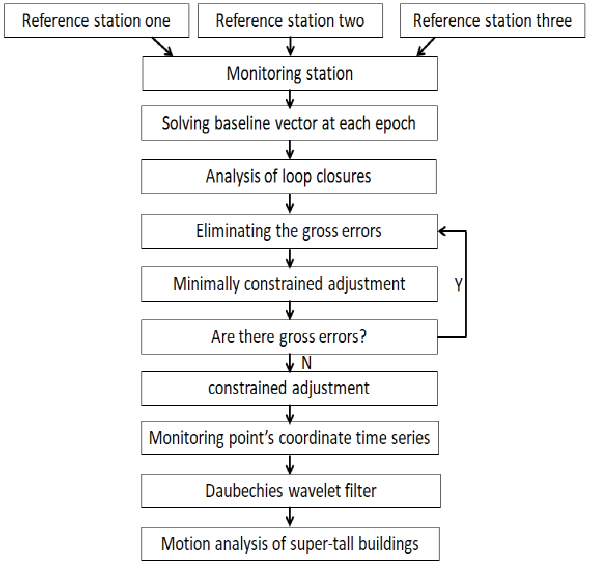
Figure 2. The flowchart diagram for calculating the monitoring point’s coordinate time series.